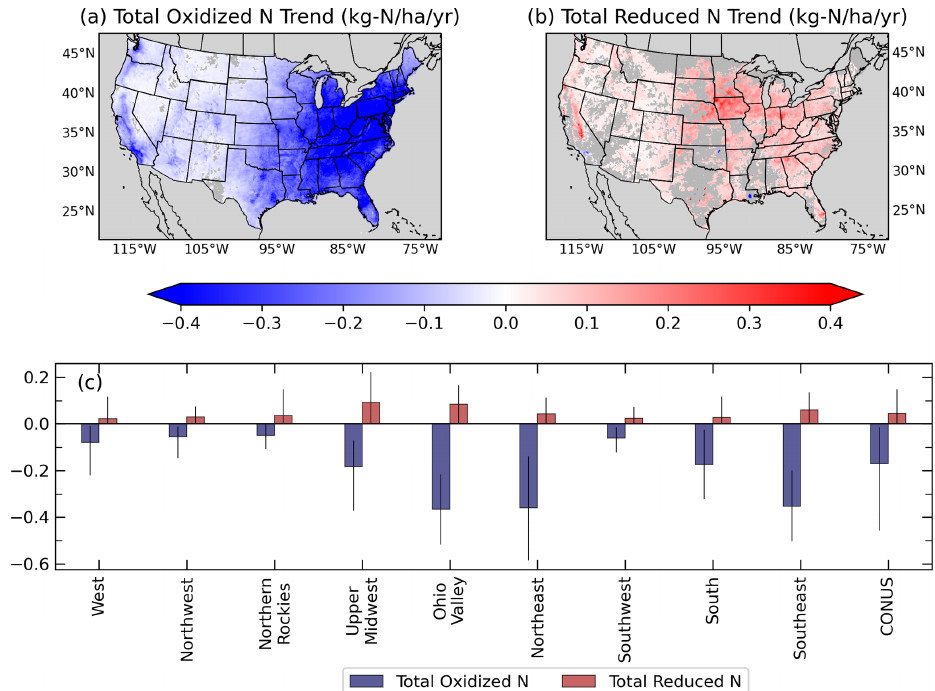
Figure 7. Maps of 2002–2017 trends of total oxidized (a) and reduced N deposition ( b , kg Nha − 1 yr − 1 ) and comparison of average trends across nine CONUS climate regions (c) . Lines in panel (c) show the 5th and 95th percentiles of the trends for each region. Grey colors on the map indicate where the trend is unavailable or